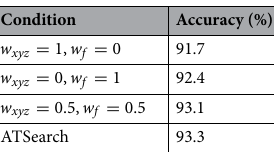
Table 4. Performance comparison under different parameter